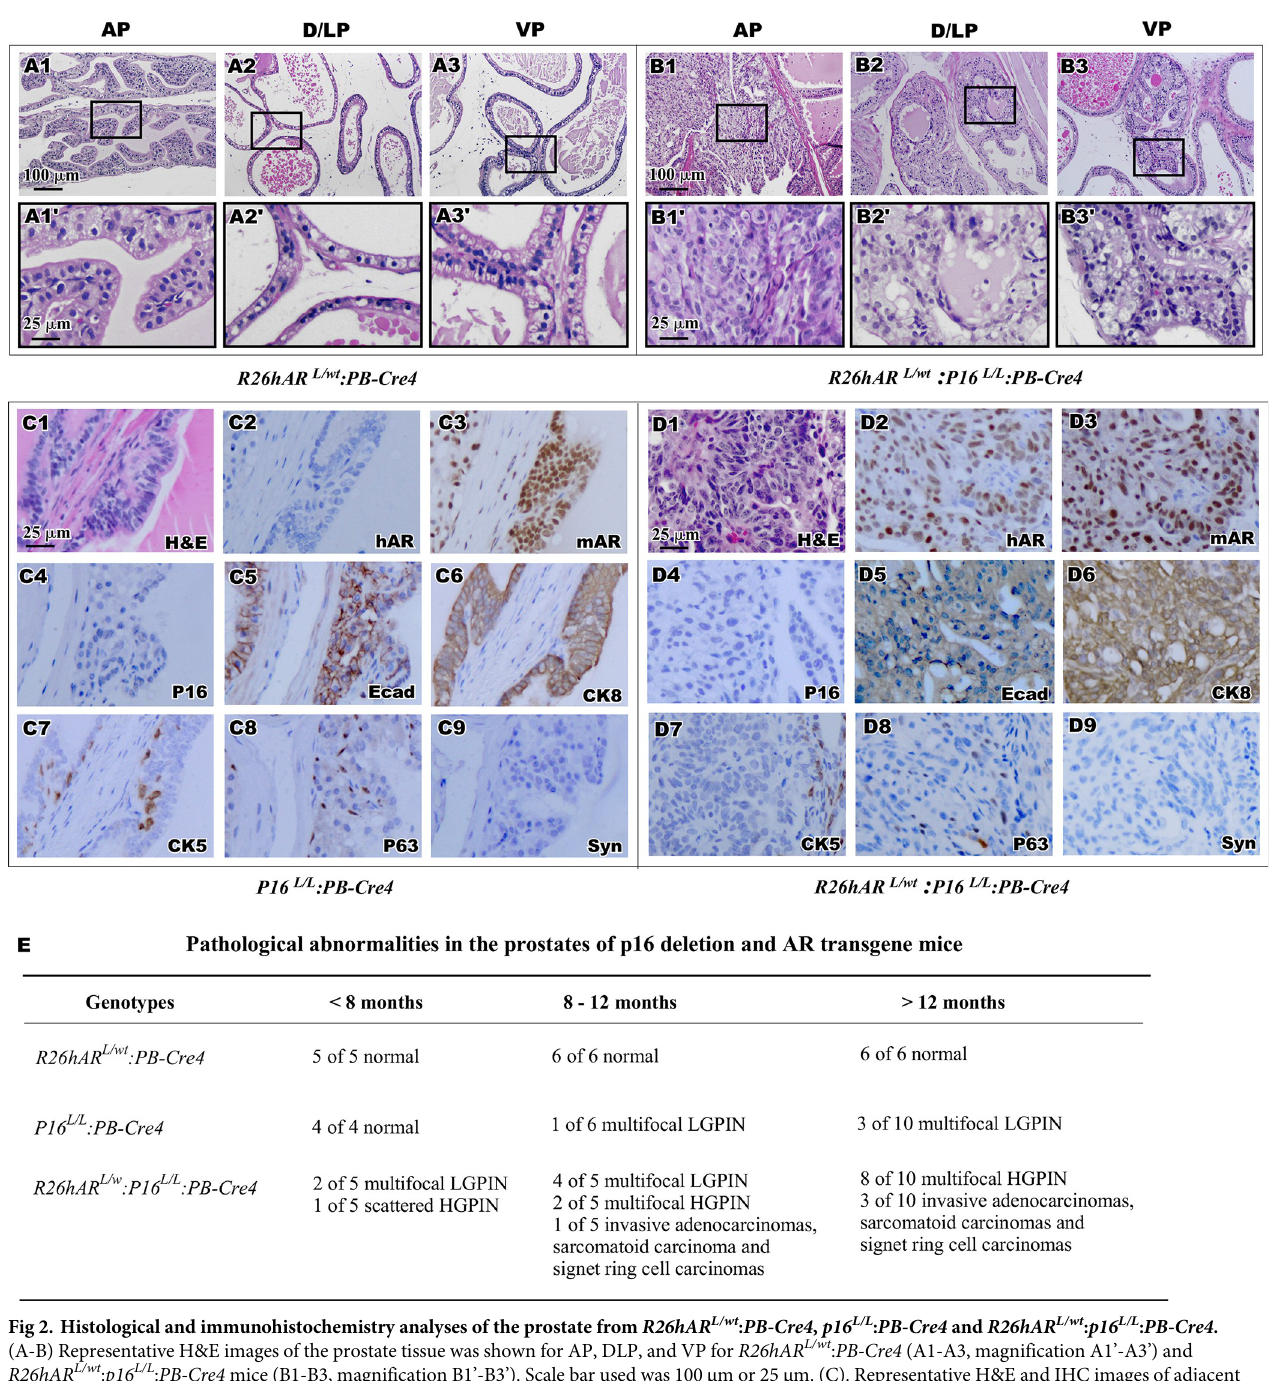
Fig 2. Histological and immunohistochemistry analyses of the prostate from R26hAR L/wt : PB-Cre4 , p16 L/L : PB-Cre4 and R26hAR L/wt : p16 L/L : PB-Cre4 . (A-B) Representative H&E images of the prostate tissue was shown for AP, DLP, and VP for R26hAR L/wt : PB-Cre4 (A1-A3, magnification A1’-A3’) and R26hAR L/wt : p16 L/L : PB-Cre4 mice (B1-B3, magnification B1’-B3’). Scale bar used was 100 μ m or 25 μ m. (C). Representative H&E and IHC images of adjacent prostate tissue sections of AP from the p16 L/L : PB-Cre4 mice were shown for staining with different antibodies as labeled in right bottom corner. (D). Representative H&E and IHC images of adjacent prostate tissue sections from the p16 L/L : R26hAR L/wt : PB-Cre4 mice were shown for staining with different antibodies (please see S1B and S1B’ Fig for positive staining of synaptophysin). Scale bar used was at 25 μ m for all panels (C1-D9). (E) Pathological abnormalities of R26hAR L/wt : PB-Cre4 , p16 L/L : PB-Cre4 , and R26hAR L/wt : p16 L/L : PB-Cre4 mice reported for different time points.